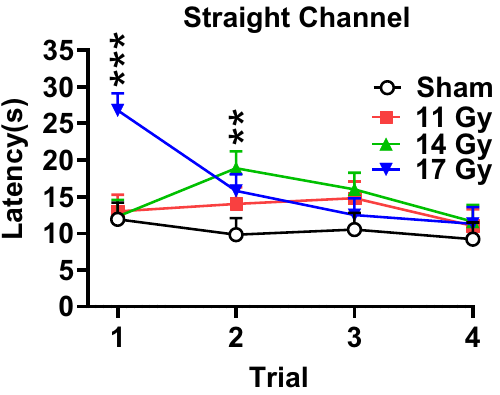
Figure 5. Straight channel swim latencies by trial to locate the hidden platform of proton irradiated and control rats. ** p < 0.01 14 Gy versus controls, *** p < 0.001 17 Gy versus controls. N =